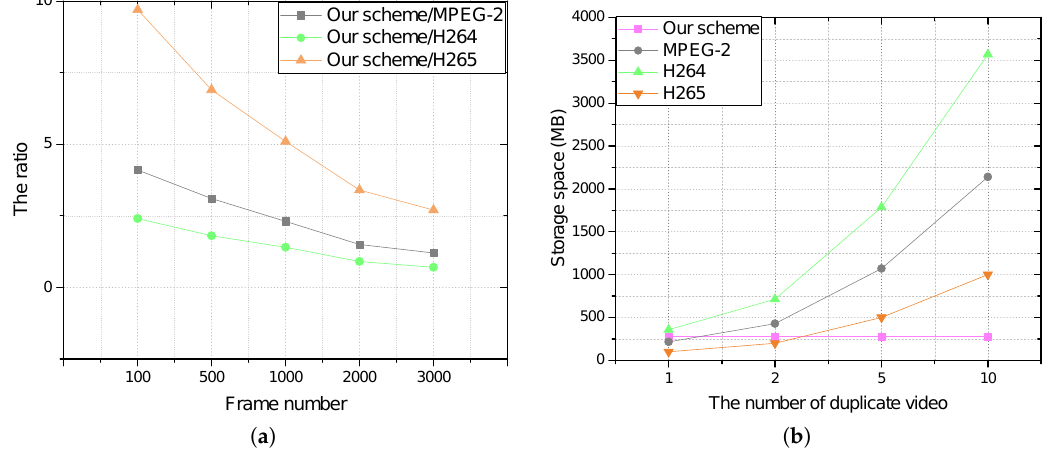
Figure 7. ( a ) The ratio of the proposed scheme to compression algorithms; ( b ) comparison of storage space between the proposed system and compression algorithms when a video is